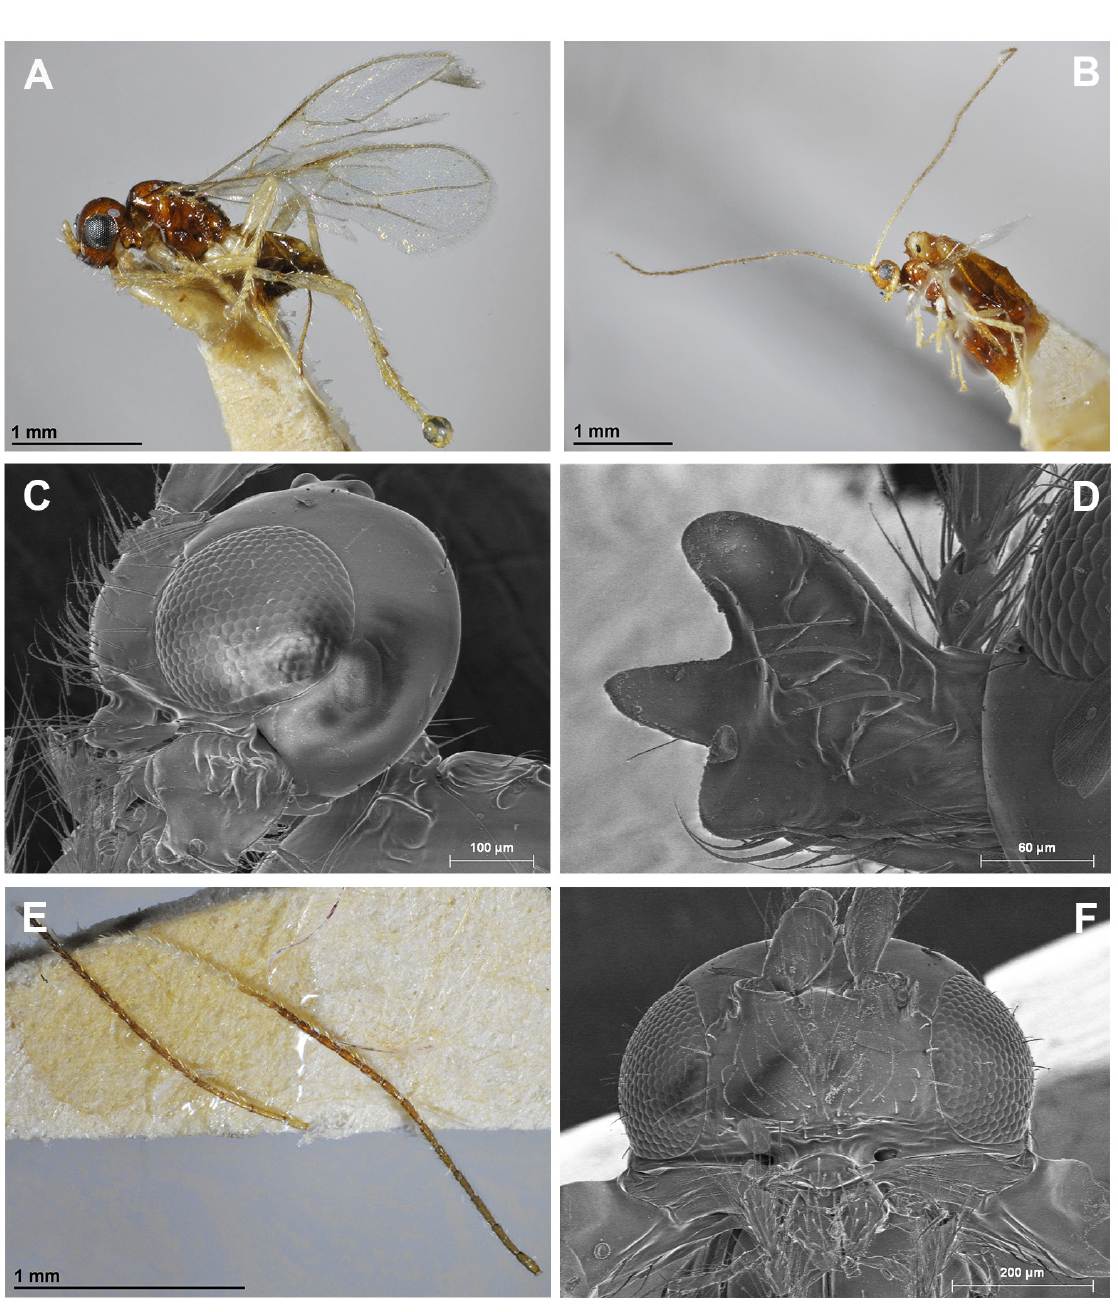
Fig. 21. Asobara glabrisulcata Fischer, 2003, A, C–F: ♀, holotype (NHMW); B: ♂ (NHMW). A–B . Habitus, lateral view. C . Head, lateral view. D . Mandible. E . Antenna. F . Head, front